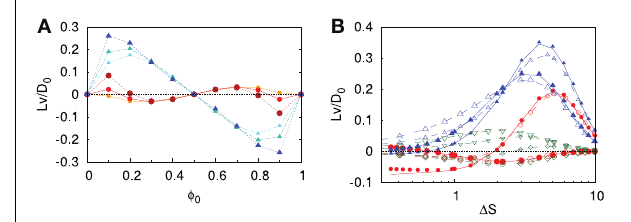
FIGURE 5 | Cooperative-rectification induced velocity of processive (circles) and non-processive (triangles) molecular motors embedded in a symmetric channel. (A) Normalized particle velocity, in units of D 0 / L with D 0 = D 0 ( R = 1 ) , upon variation of the phase shift φ 0 for different values of the parameter (cid:3) S = 1 . 73 , 2 . 19 , 2 . 94 (the larger the symbol size, the larger (cid:3) S ), for V 1 = 0 . 2 and ω 2 , 1 / ω 1 , 2 = 0 . 01. (B) Normalized velocity, in units of D 0 / L , against entropic barrier for processive (circles), non-processive (triangles) molecular motor as a function of (cid:3) S upon variation of particle radius R (solid lines, for h 0 = 1 . 25 , h 1 = 0 . 2), h 0 (solid points, for R = 1 , h 1 = 0 . 2) or h 1 (open points, for R = 1 , h 0 = 1 . 25) for φ 0 = 0 . 1 , 0 . 2(larger symbols correspond to larger φ 0 ). As a comparison, the case for φ 0 = 0 . 1 , 0 . 2 and V 1 = 0 . 2 is shown (green diamonds) (the larger the symbol the larger φ 0 ) with ω 2 , 1 / ω 1 , 2 = 0 . 01. (The curves for V 1 = 1 have been magnified by a factor of 5 for the sake of clarity). Reprinted with permission from (59). Copyright (2013) by the American Physical Society.